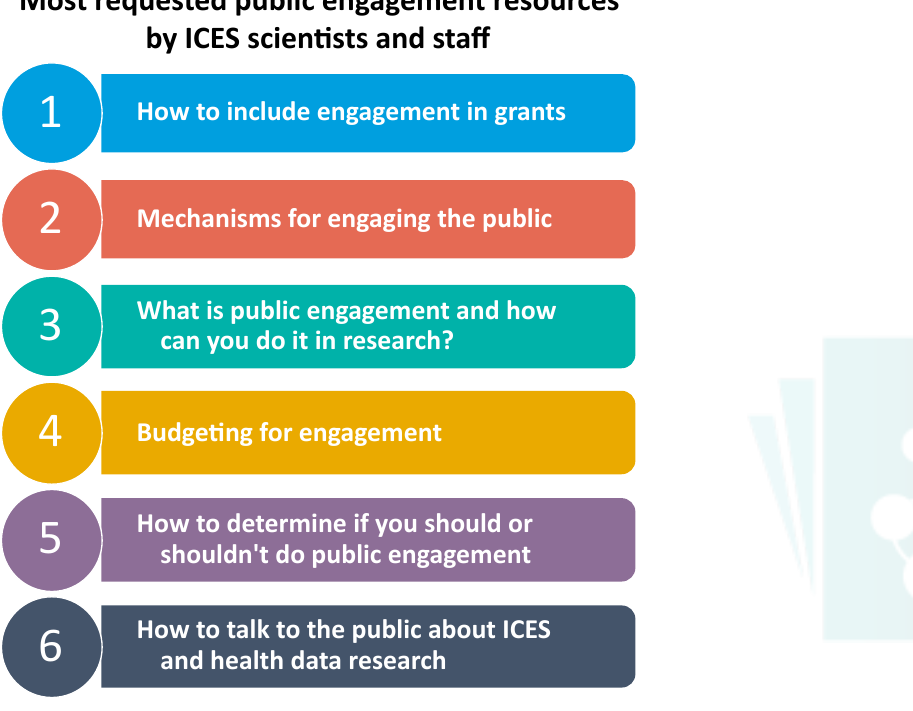
Figure 4: Most requested public engagement resources by ICES scientists and